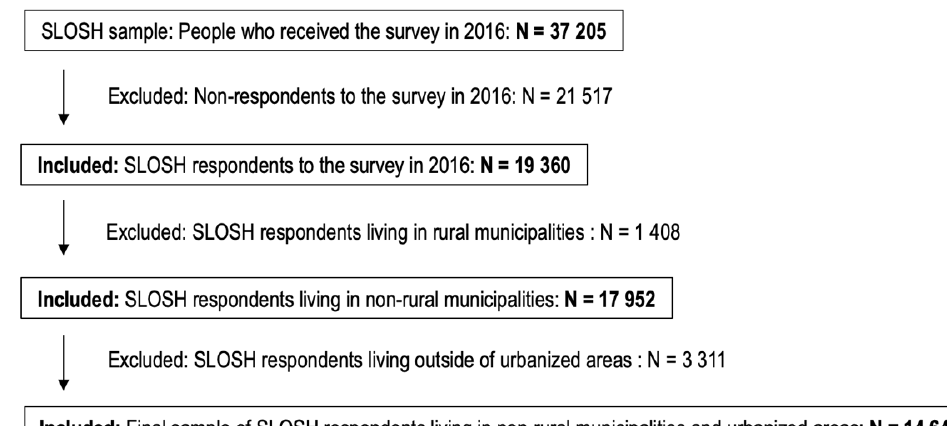
Figure 1. Participant sample, inclusion